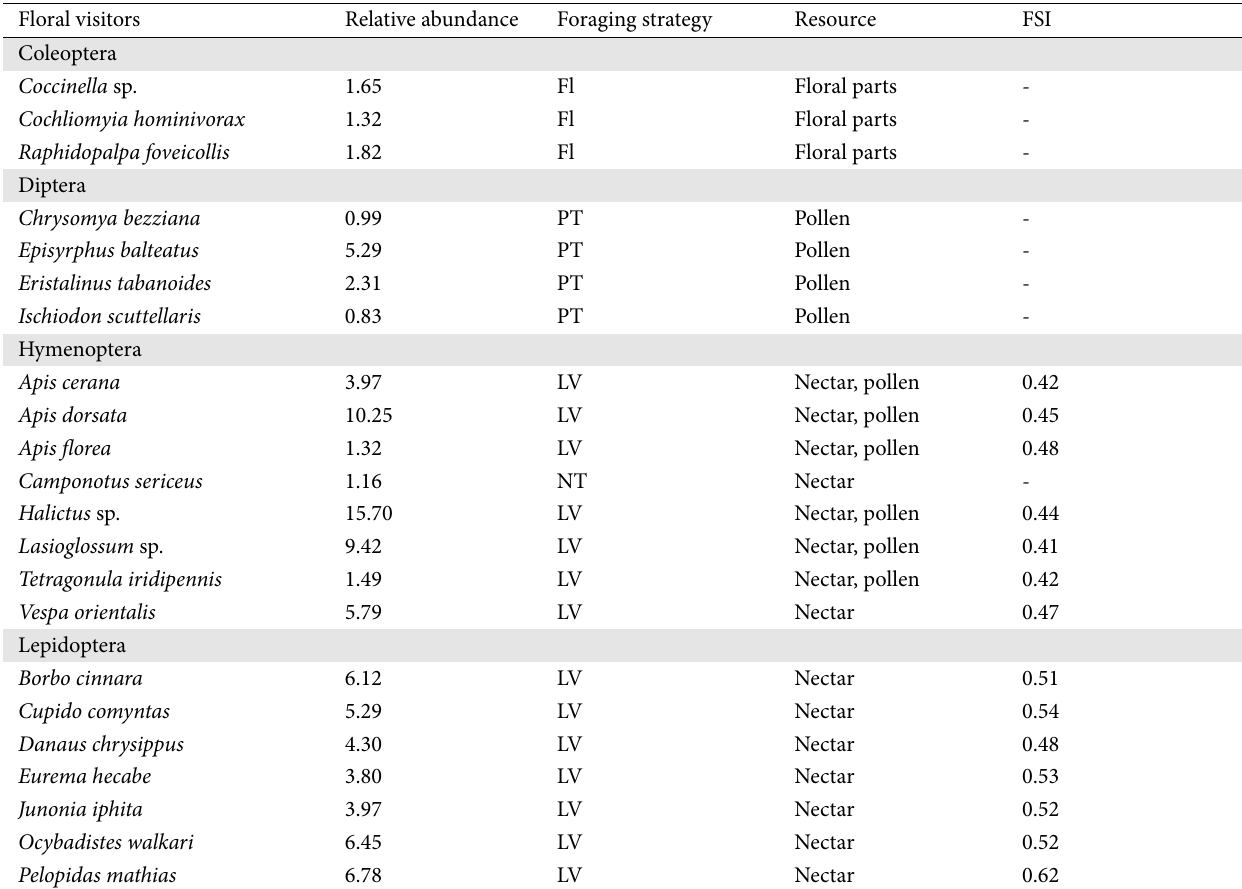
Table 2 Floral visitors of Momordica charantia in open condition in West Bengal, India. Floral visitors